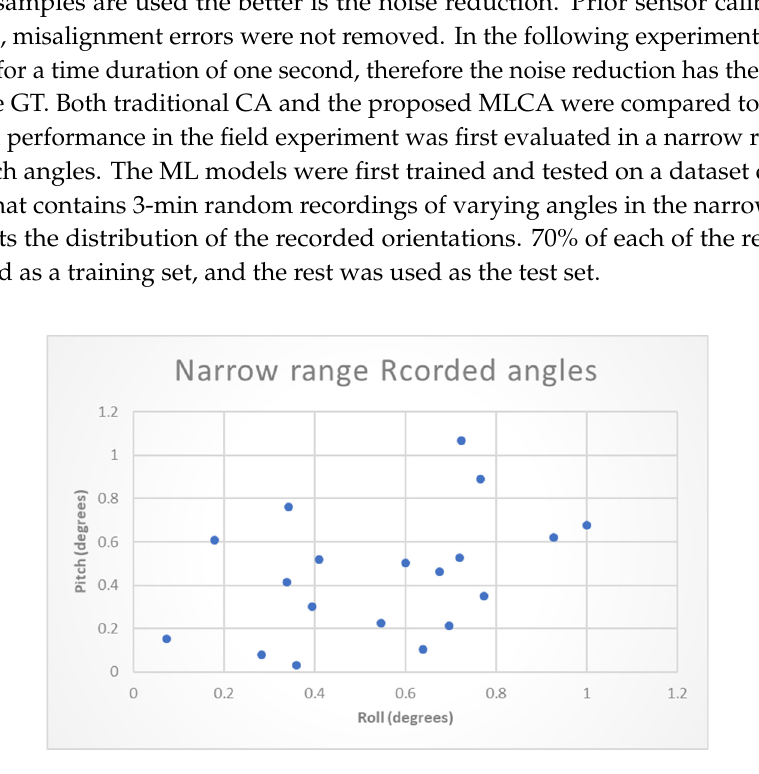
Figure 9. Experiment narrow range recorded angles distribution.